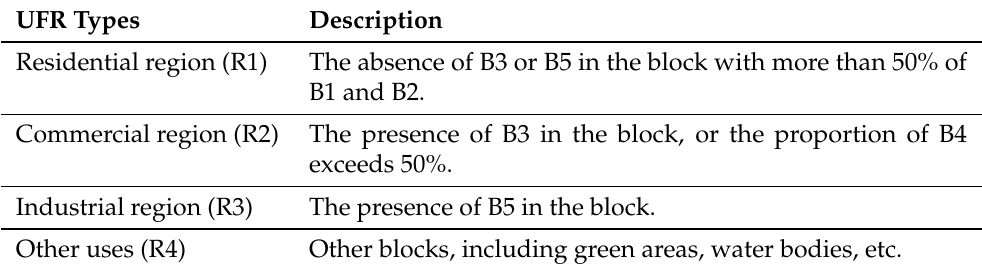
Table 2. Decision rules for urban function regions based upon different building types